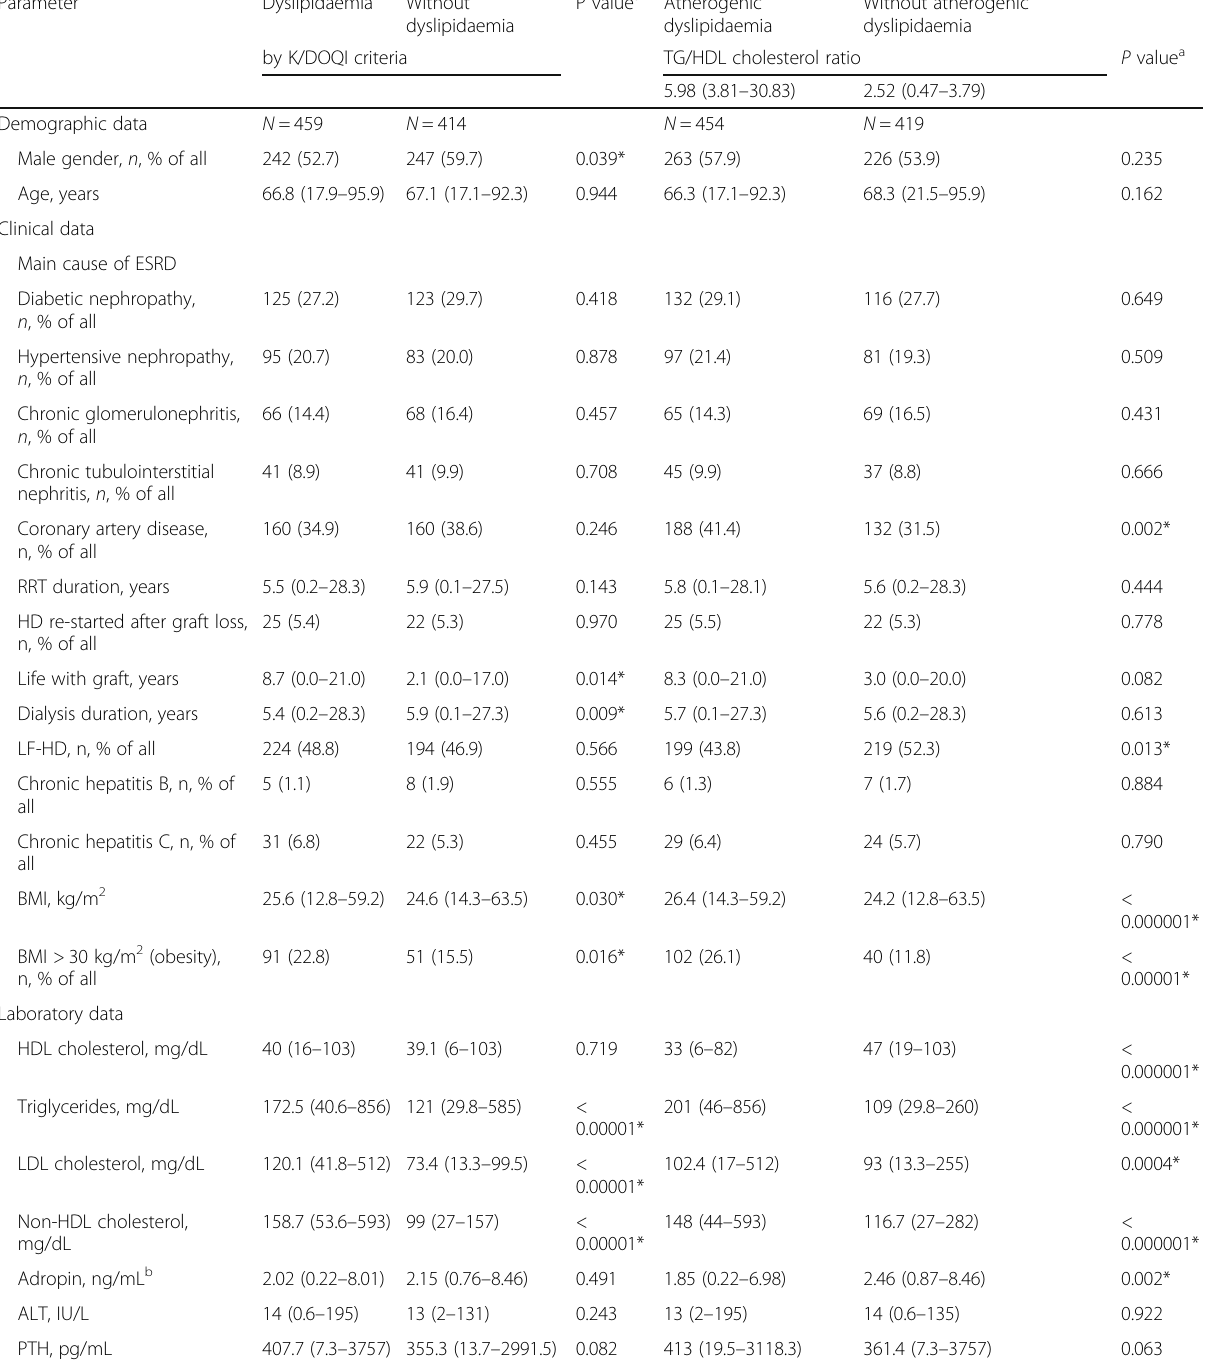
Table 1 Demographic, clinical and laboratory data of HD patients stratified by type of